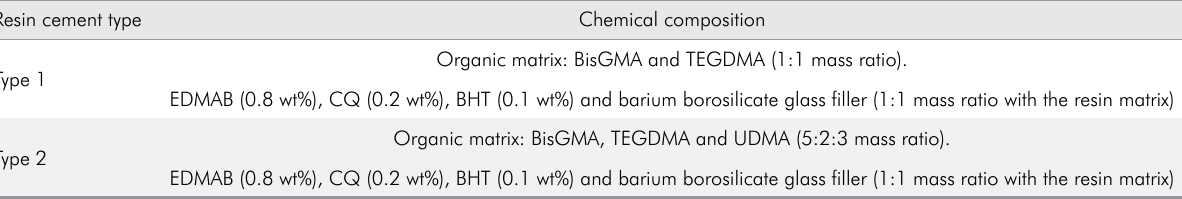
Table 1. Resin cements chemical composition. Resin cement type Chemical